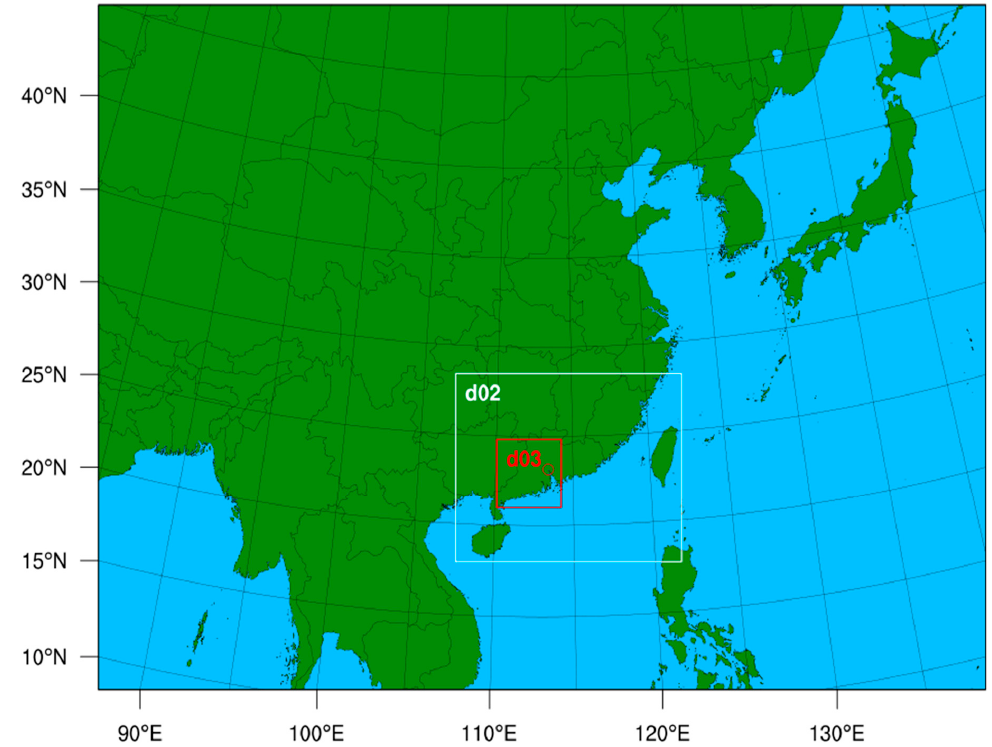
Figure 1. Study region of Guangzhou showing the three domains used in the WRF-Chem model: d01 (black), d02 (white), and d03 (red). The red circle represents the location of the monitoring station. Table 2. Details of parameterization schemes used in the WRF-Chem model.